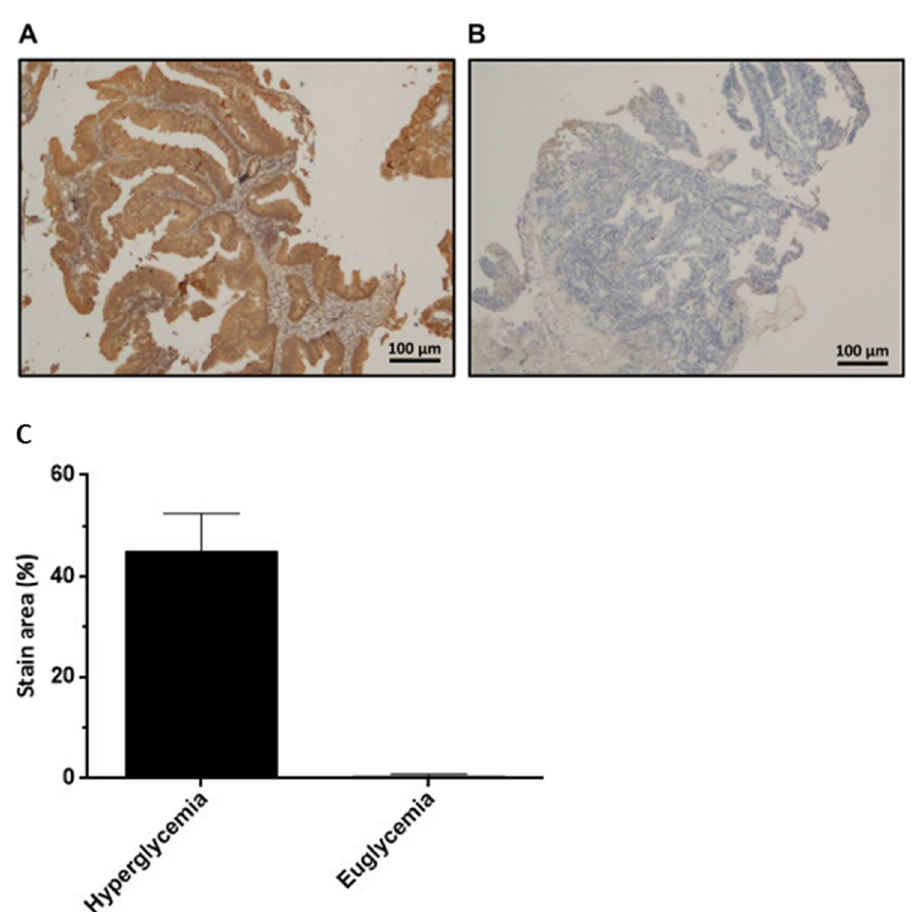
Figure 1. Representative immunohistochemical staining of HIF-1 α in rectal cancer specimens. High ( A ) and low ( B ) levels of HIF-1 α in rectal cancer specimens. Scale bar with microscope magnified 100 times. ( C ) The HIF-1 α staining in rectal cancer specimens also quantitated by image J. soft.